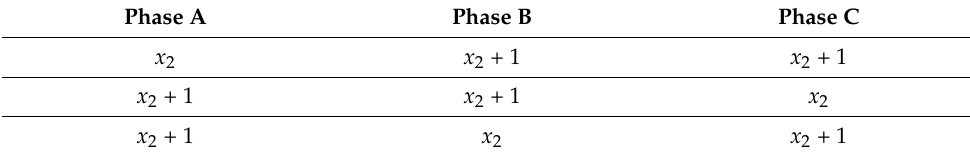
Table 4. Slot distribution to phases of UBW type B